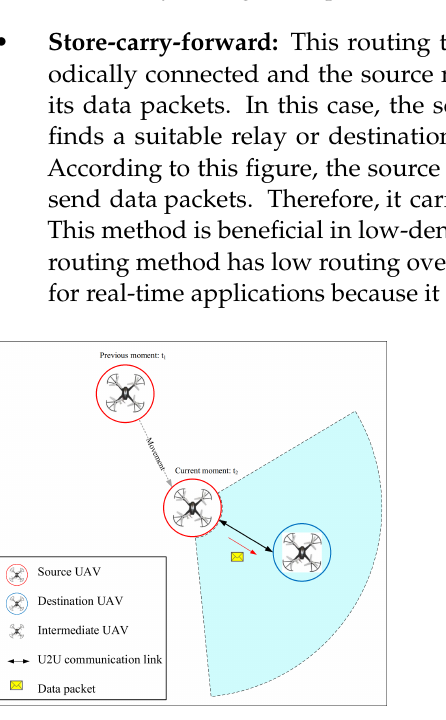
Figure 18. Store-carry-forward